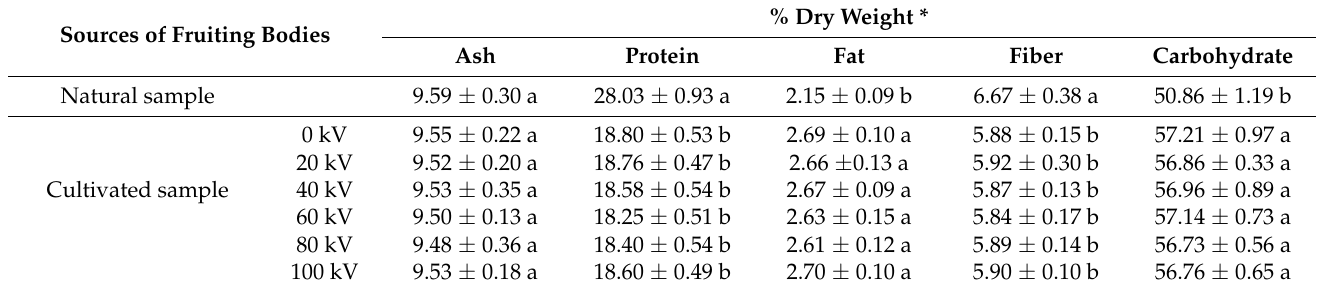
Table 4. Proximate composition on a dry basis (% dry weight) of different mushroom